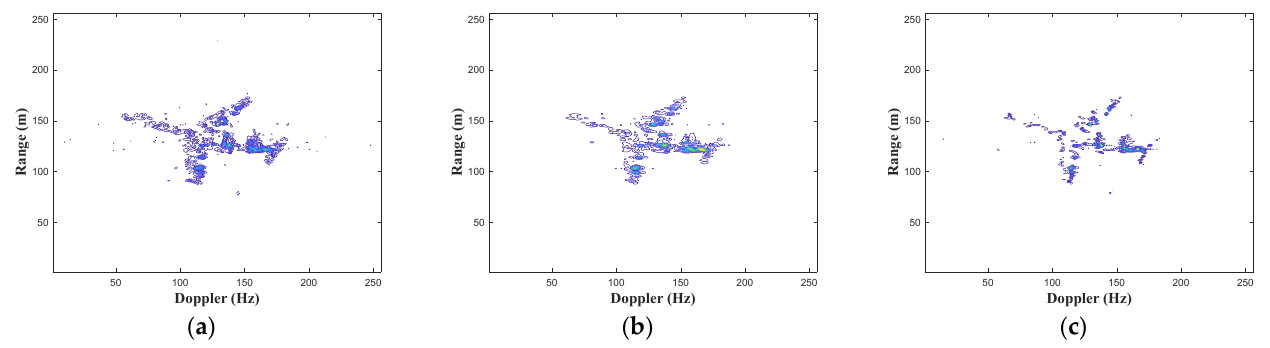
Figure 13. The recovered image using the Burg method. ( a ) 128 pulses. ( b ) 64 pulses. ( c ) 32 pulses.